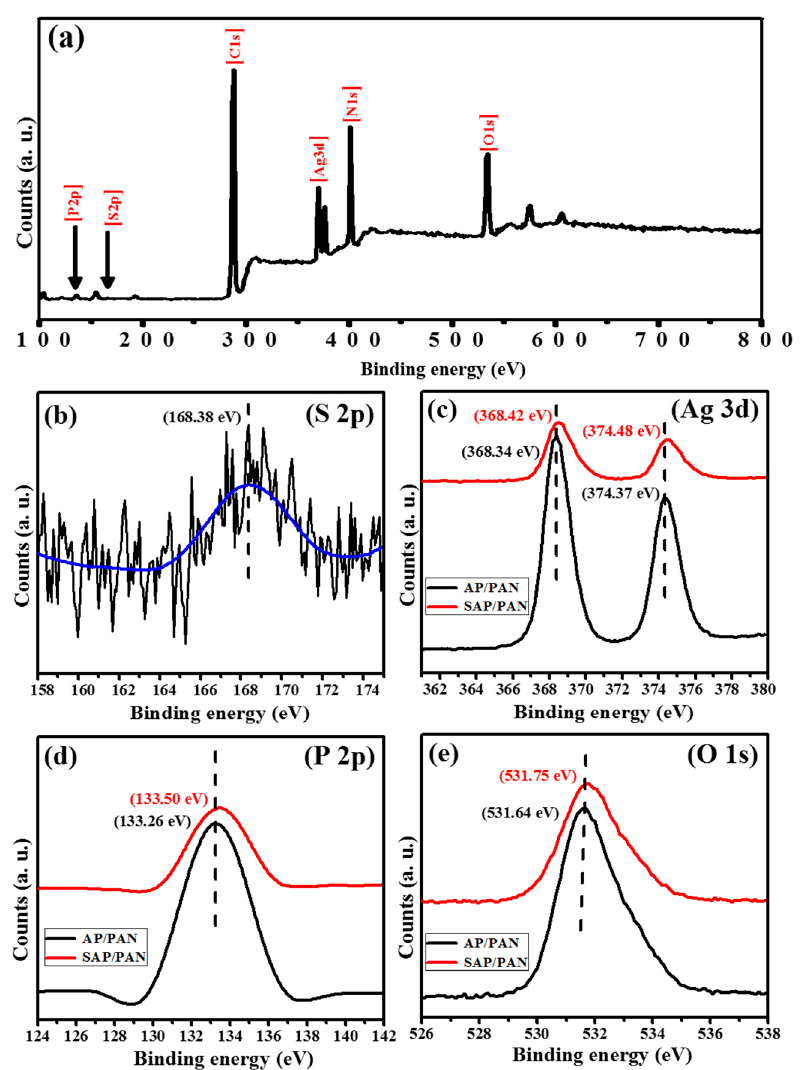
Figure 5. XPS spectra; survey spectrum of SAP / PAN ( a ). Panels ( b – e ) represent the high-resolution spectra of AP / PAN and SAP / PAN.